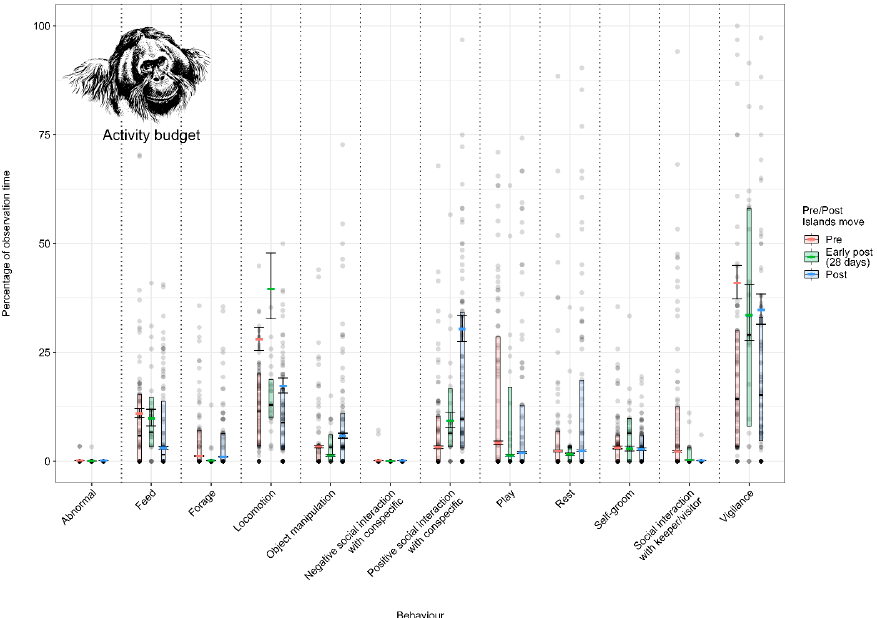
Figure 2. Proportion of time Sumatran orangutans spent performing each behaviour (expressed as a percentage of the total observation time) under the pre-, early-post- and post-enclosure-move conditions. The model’s fitted values are represented by coloured horizontal lines, and their respective 95% confidence intervals are depicted as black error bars. Coloured boxes with black horizontal lines depict the medians and quartiles of the response. Grey dots represent raw data points, shaded according to frequency (dark indicates many observations, light indicates few). Individuals spent less time feeding (from 9.2% (±1.0) to 4.3% (±1.0)) and locomoting (from 11.4% (±0.7) to 8.5% (±0.8)) between the pre- and post-move conditions. Addition- ally, macaques spent more time self-grooming (4.8% (±0.7), increasing to 10.5% (±1.3)) be- tween the pre- and post-move condition (Figure 3; Appendix C, Table A9).